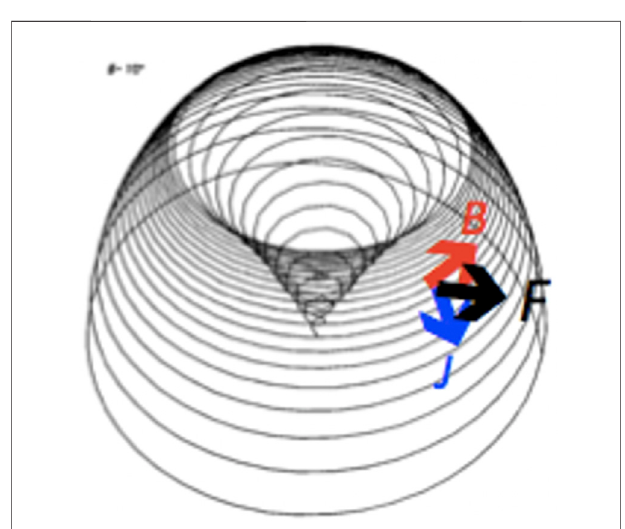
FIGURE 2 | One of the magnetic fi eld lines generated by the solar unipolar induction current system. The current J, magnetic fi eld direction B and the direction of the outward force F by the ( J x B ) force are